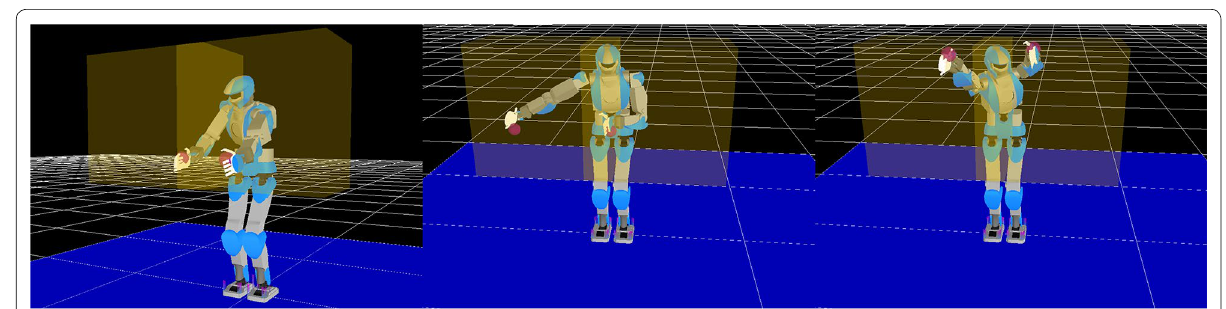
Fig. 3 Humanoid’s postures obtained from the SVR and the inverse kinematics of the